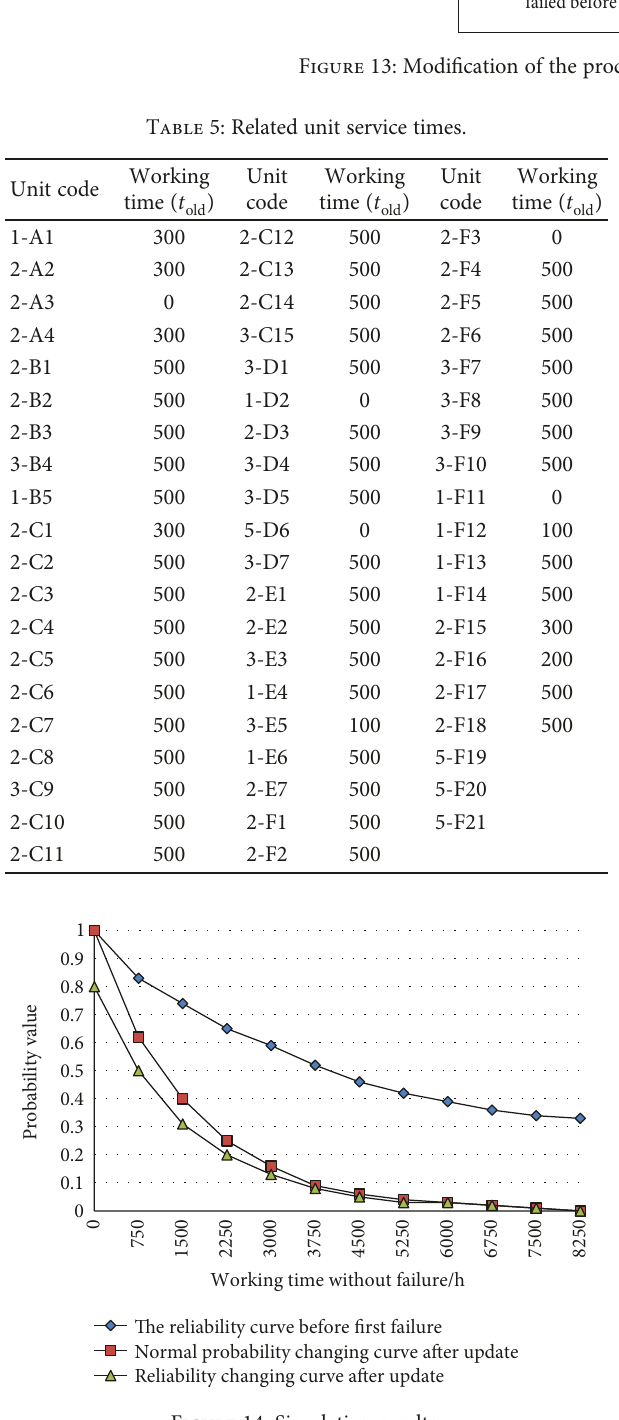
Figure 14: Simulation